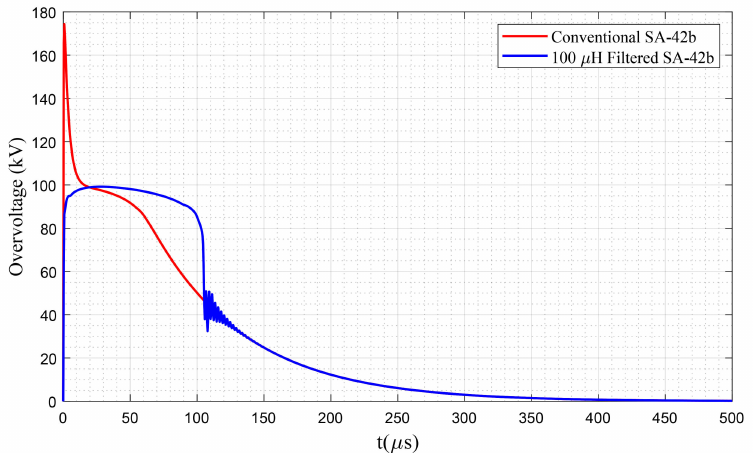
Figure 27. Comparison of the overvoltage stress of MV transformer protected by conventional SA-42b (red curve) and 100 µ H filtered SA-42b (blue curve) under the 200 kV lightning